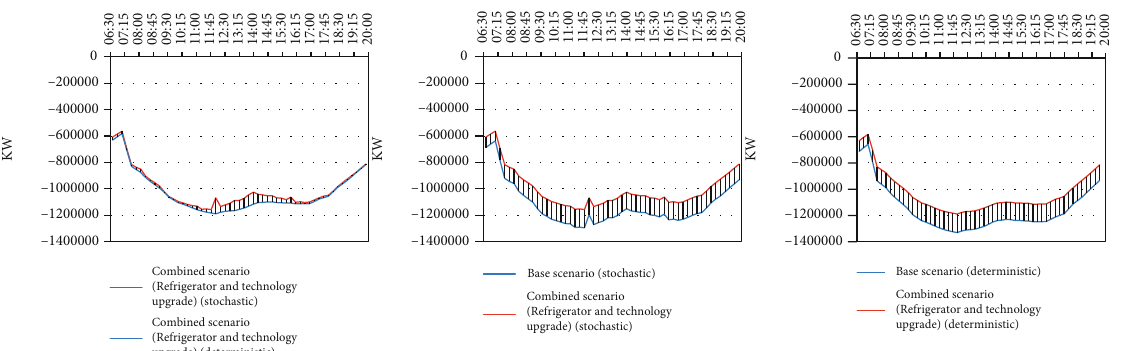
Figure 26: Di ff erent modes in the combined scenario (refrigerator and technology upgrade)